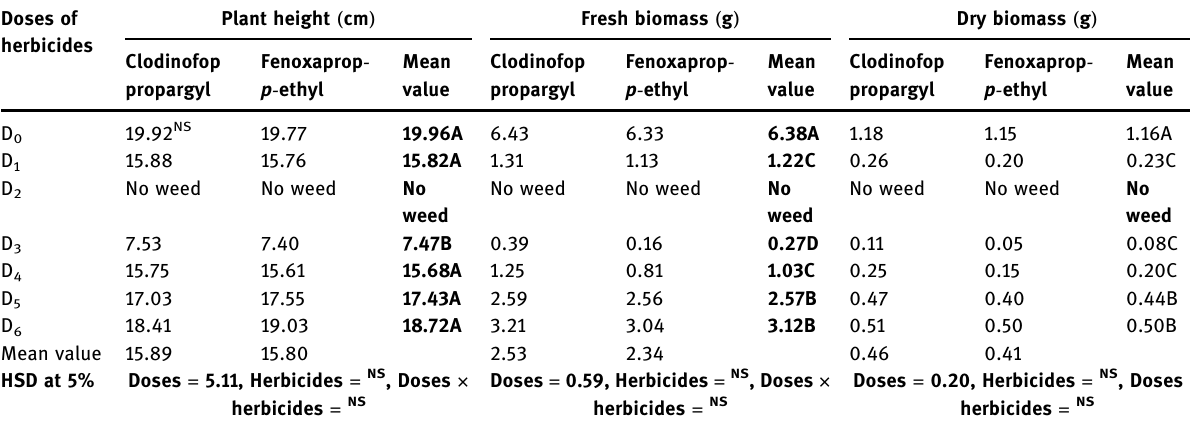
Table 2: E ff ect of NPs of clodinofop propargyl and fenoxaprop - p - ethyl on plant height ( cm ) , fresh biomass ( g ) , and dry biomass ( g ) of P. minor Doses of